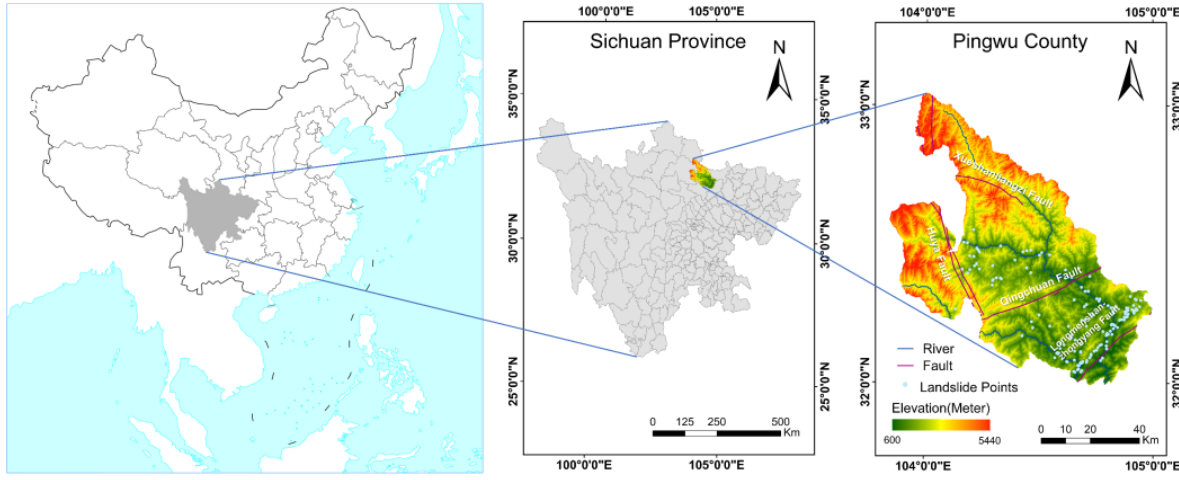
Figure 1. Study area and landslide distribution.